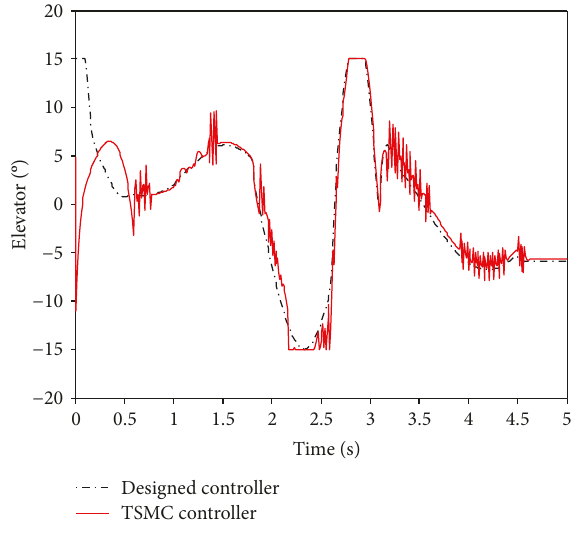
Figure 8: Elevator de fl